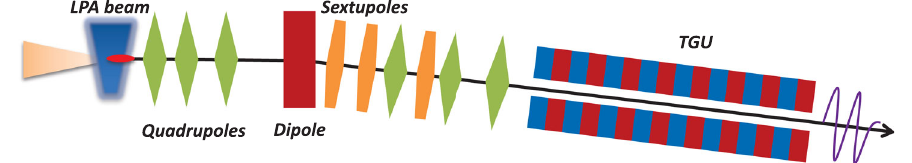
FIG. 1. Scheme of the proposed LPA beam transport system combining to TGU.